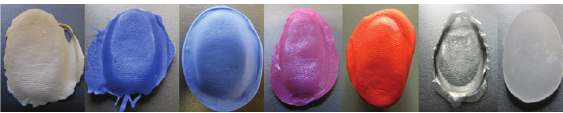
Figure 4: Examples of fingerprint fakes of di ff erent materials.